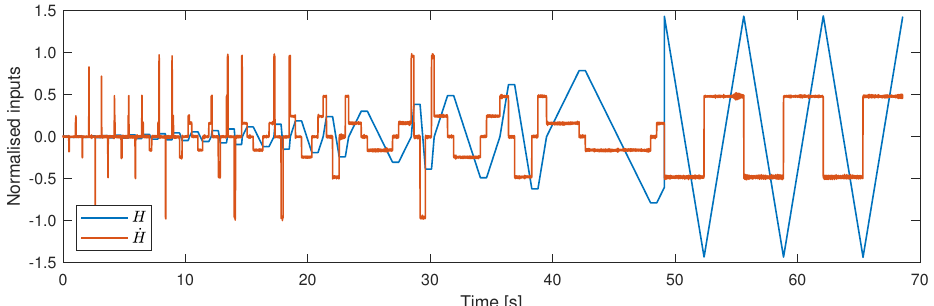
Figure 6. Magnetic field data and its derivative used for evaluating the